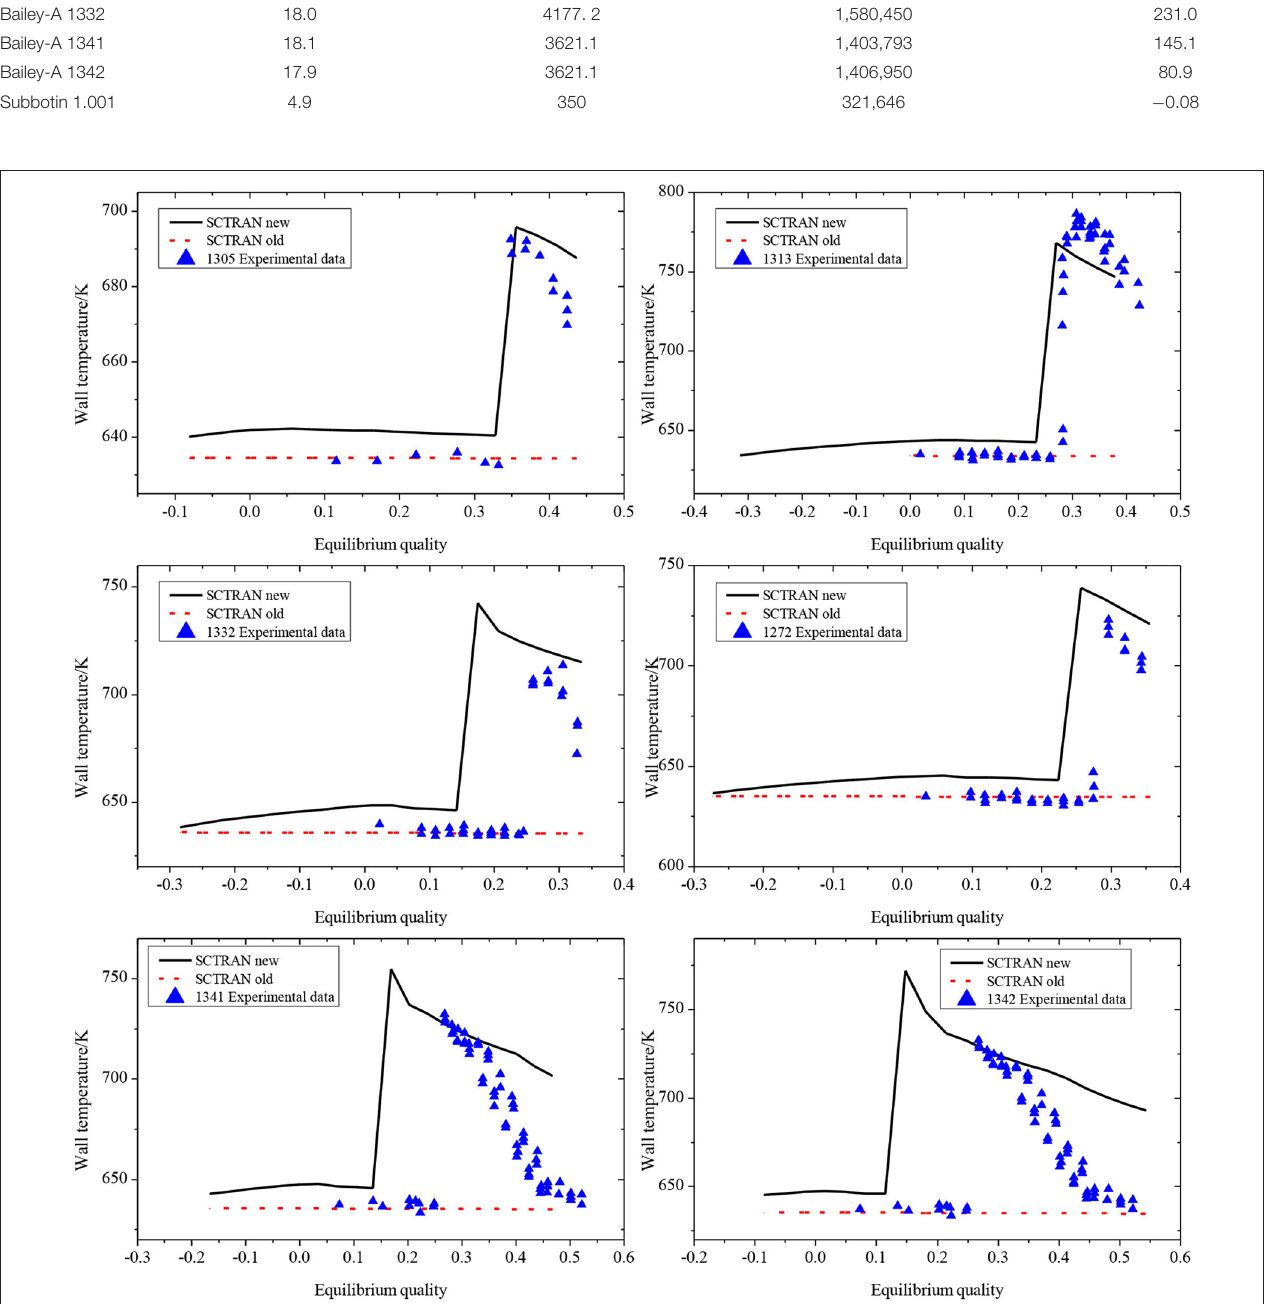
FIGURE 6 | Variation of the Wall Temperature in Bailey Experiment.